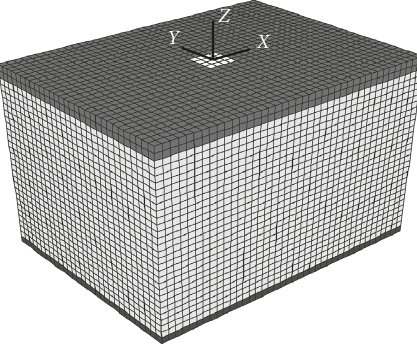
Figure 4: Model of the free